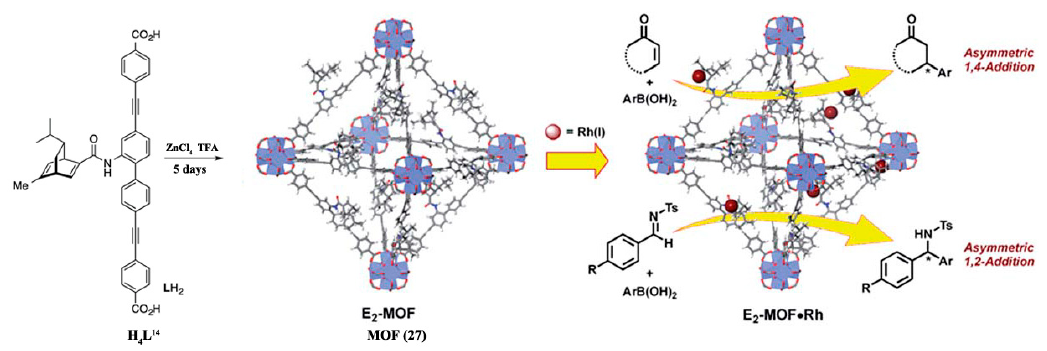
Figure 12. Synthesis of the homochiral E 2 -MOFs ( 27 ) from H 4 L 14 and its post-synthetic metalation and their application in asymmetric catalysis. Reproduced from [91] with permission from the Royal Society of Chemistry.